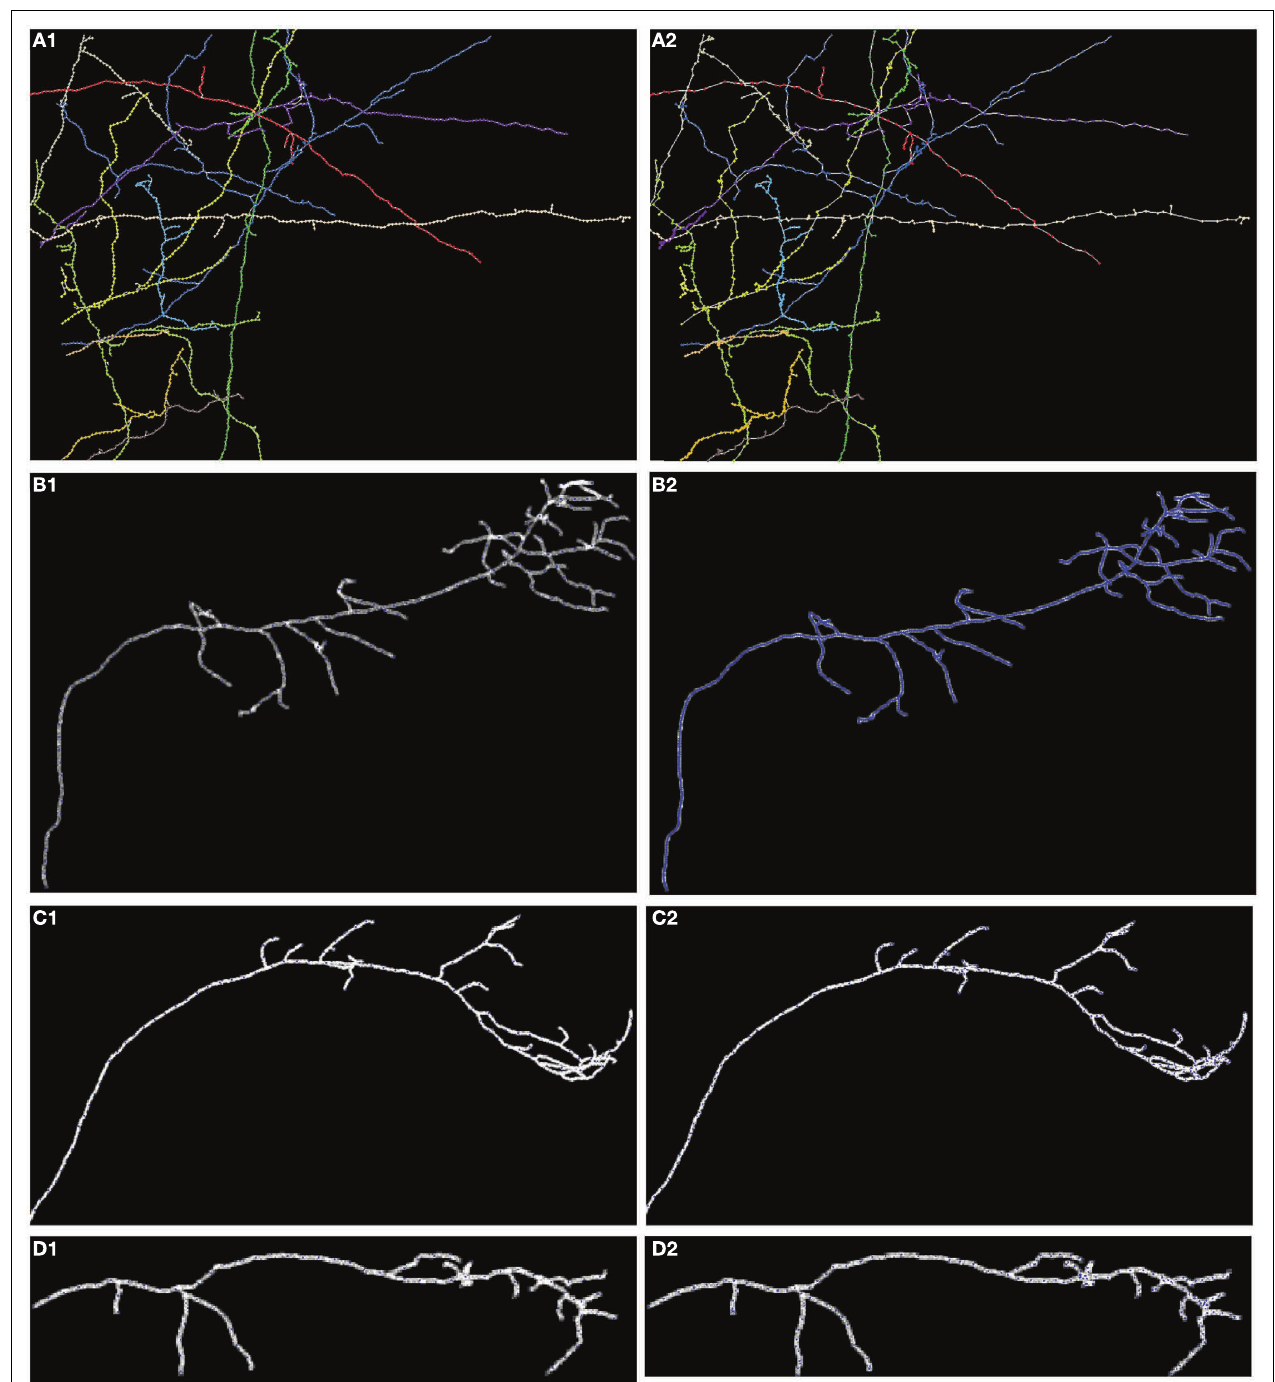
FIGURE 11 | Maximum intensity projection of: (A) neocortical layer 6 axons; (B) olfactory projection fibers OP1; (C) OP2; (D) OP3; with superimposed reconstruction (A1–D1) and ground truth (A2–D2). Each color represents a different tree.